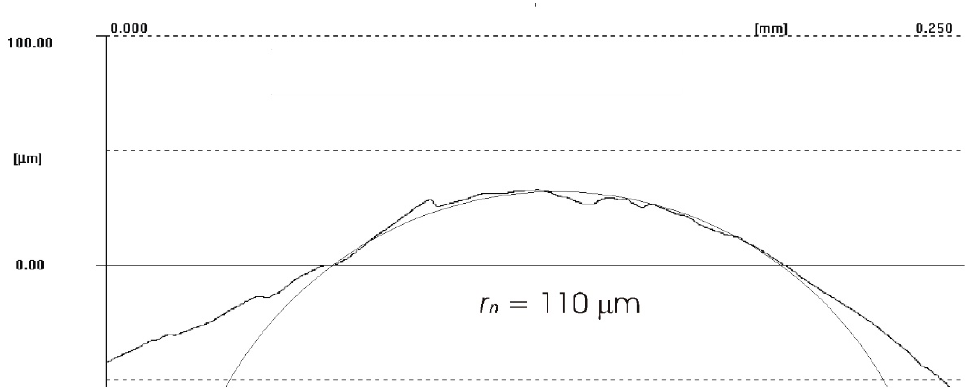
Figure 23. Cutting edge radius r n of the worn cutting insert after longitudinal turning without coolant (23 HRC).